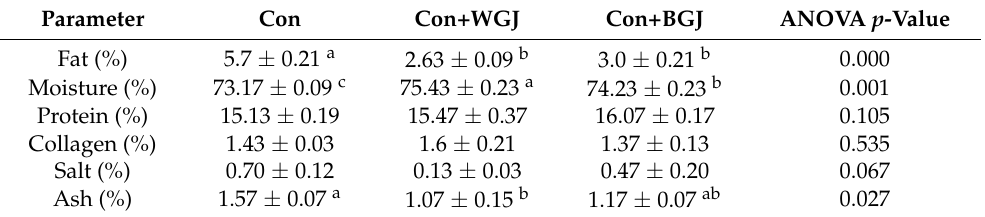
Table 4. Proximate common carp meat composition fed with a plant-based diet supplemented with 2% wheat grass juice (WGJ) and barley grass juice (BGJ).